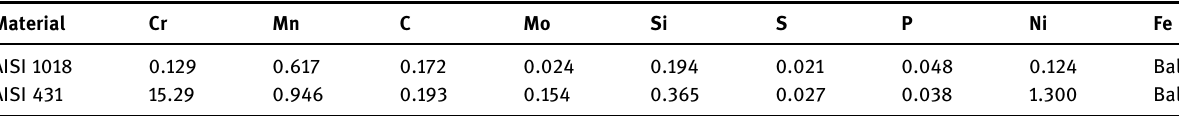
Table 1: Chemical composition ( wt% ) of AISI 1018 steel plate and AISI 431 steel rod Material